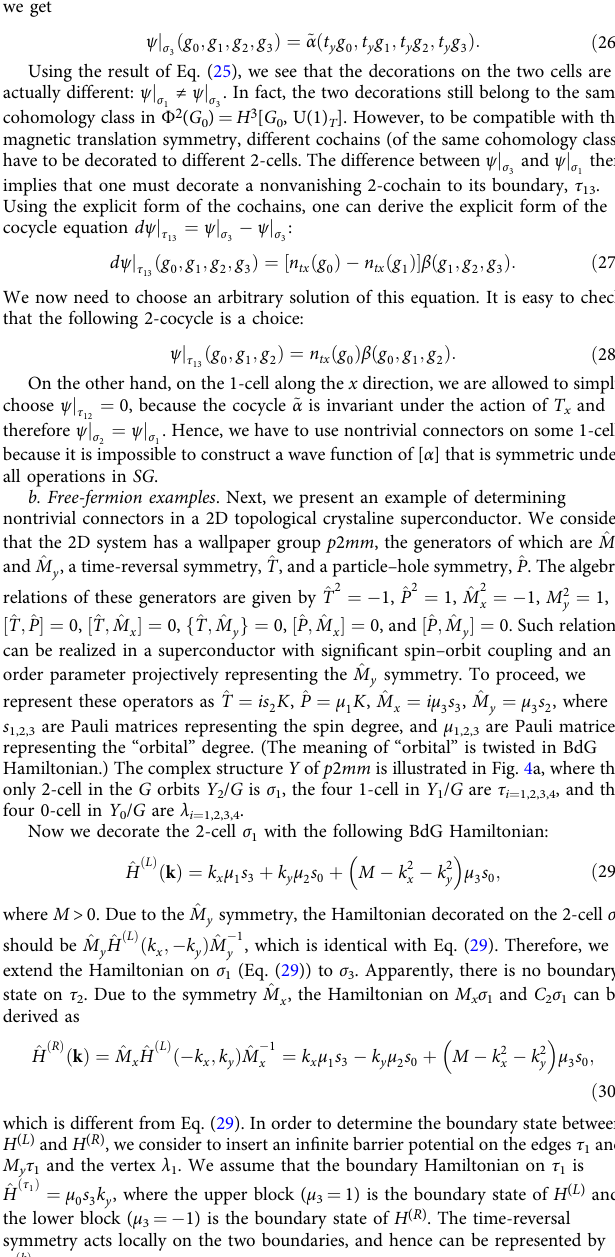
Fig. 3 The cell decomposition for the magnetic translation symmetry group. The x and y axes are the two translation axes. σ i label 2-cells, and τ ij labels the 1-cell between two 2-cells σ i and σ j . The red dot labeled by λ is a